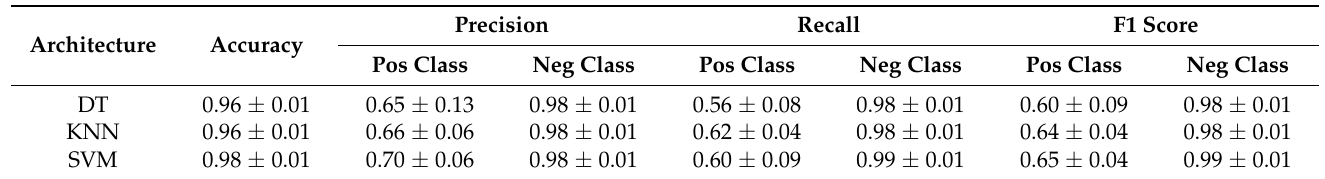
Table 3. The experimental outcome of workflow III using all employed techniques. Pos and Neg represent the positive and the negative classes,